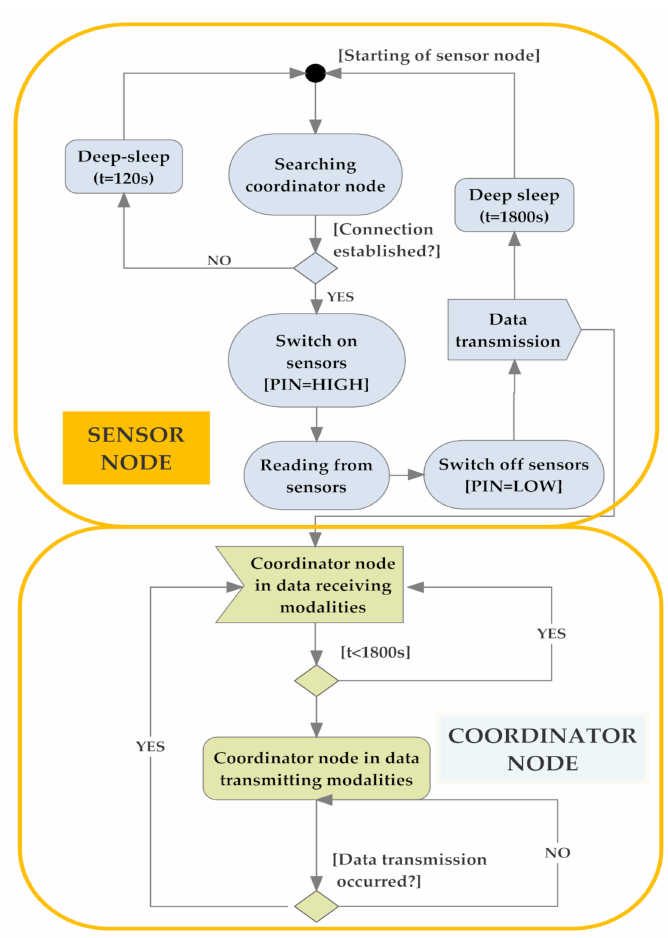
Figure 9. Flowchart related to operations performed by a generic sensor node and the corresponding coordinator